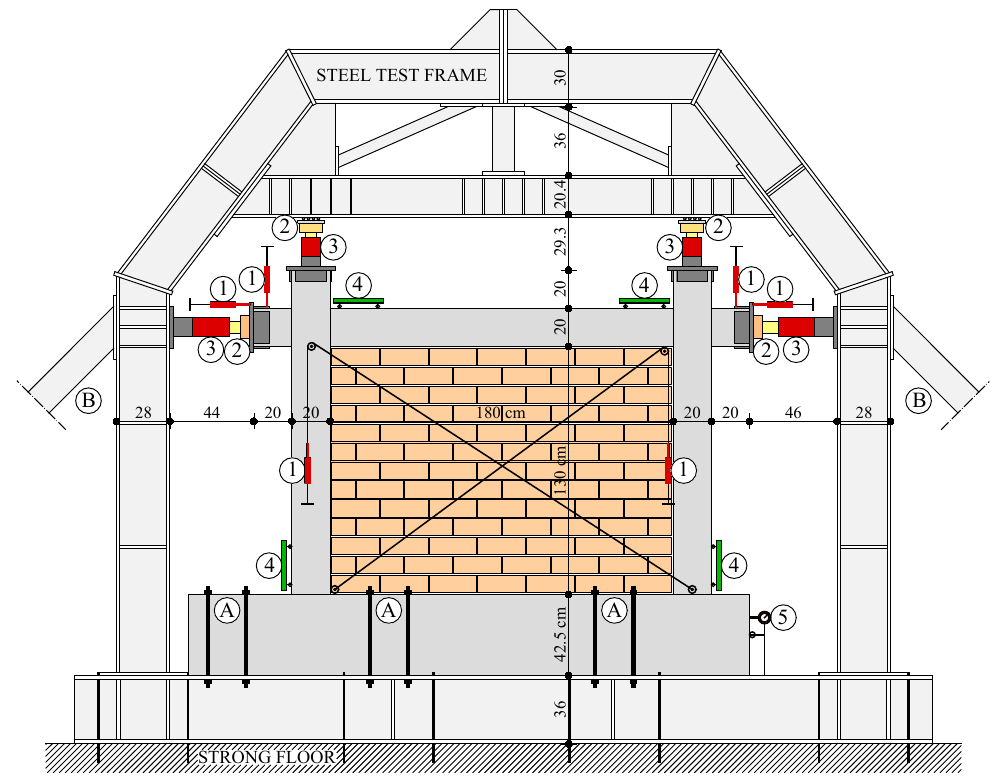
Figure 3. Test setup with loading and measuring instruments (where (A) bolts, (B) inclined steel braces, (1) LVDTs, (2) force transducers, (3) hydraulic actuators, (4) deformeters (extensometers) and (5) dial gauge). Vertical actuators contain rollers supported by a steel beam, to ensure horizontal sliding boundary condition.